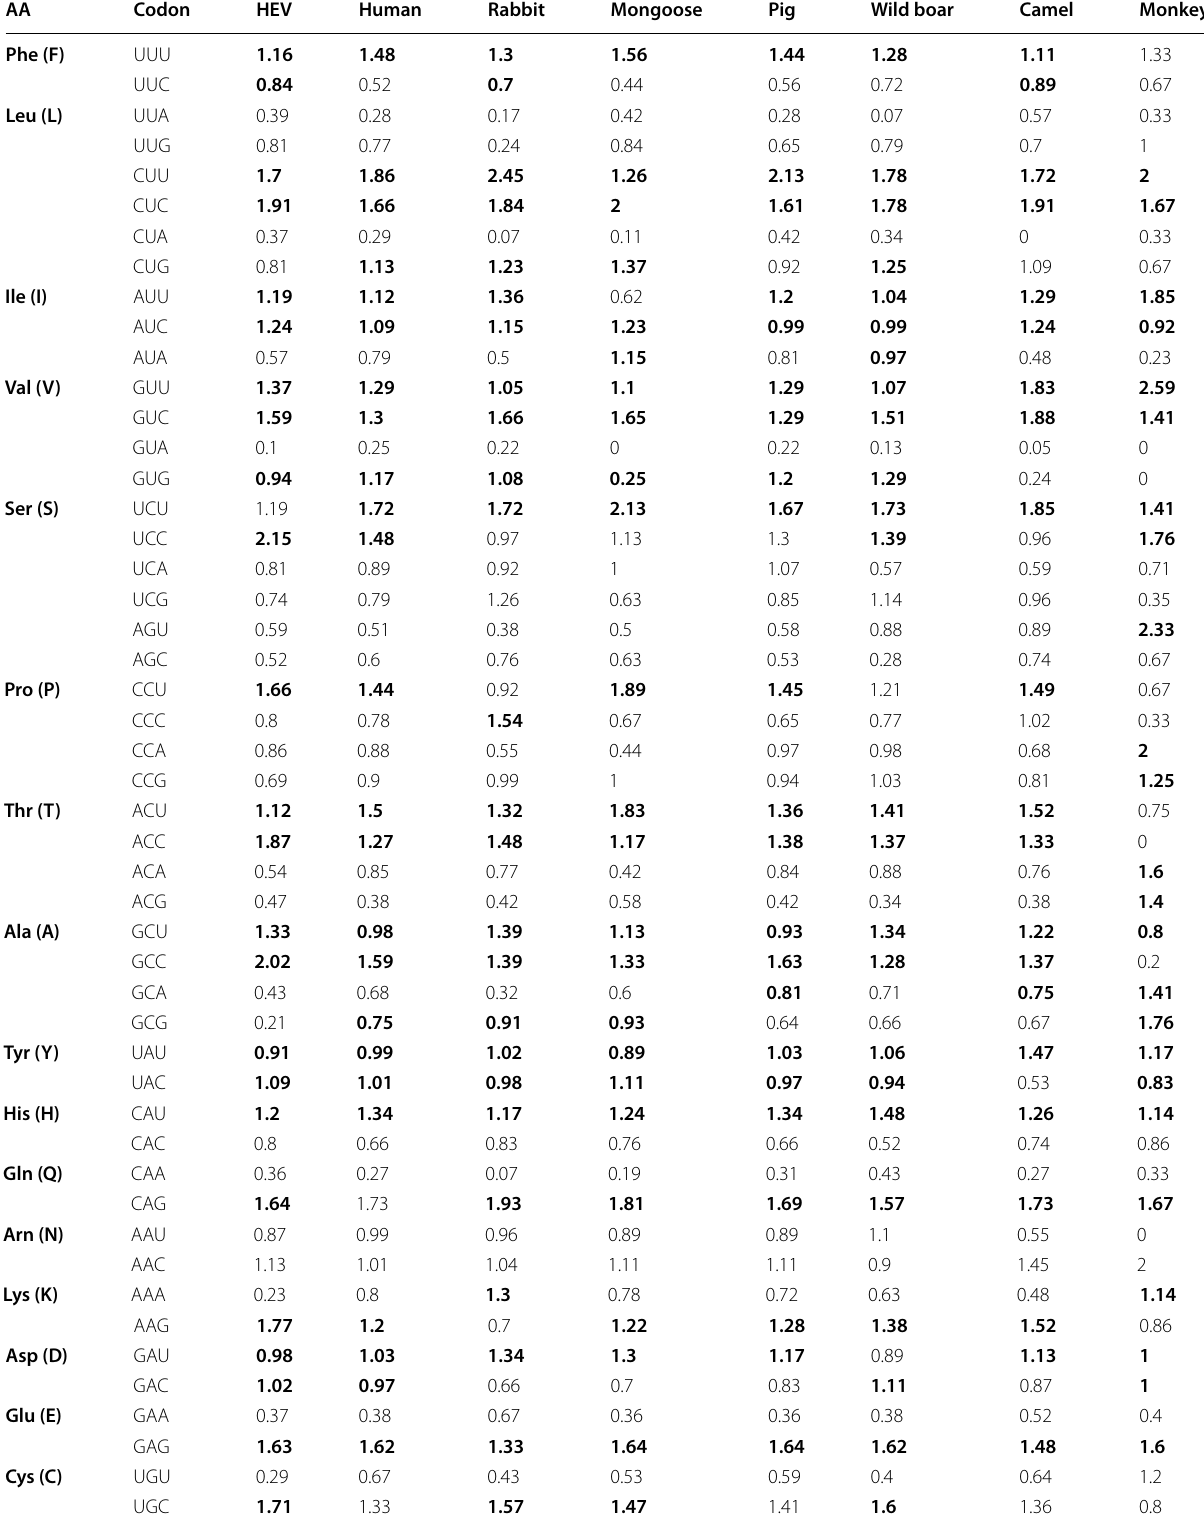
Table 2 Average RSCU values of the codons of the HEV YDR and comparison with the RSCU values of its natural hosts AA Codon HEV Human Rabbit Mongoose Pig Wild boar Camel